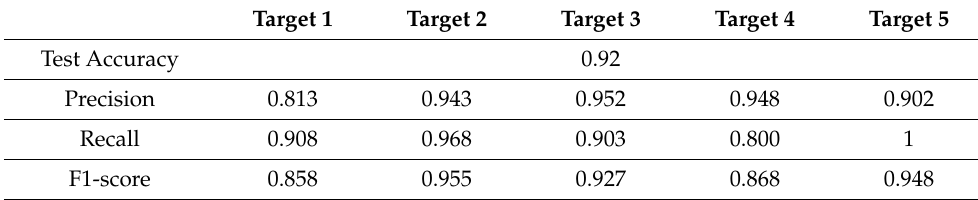
Table 8. The classification performance with data